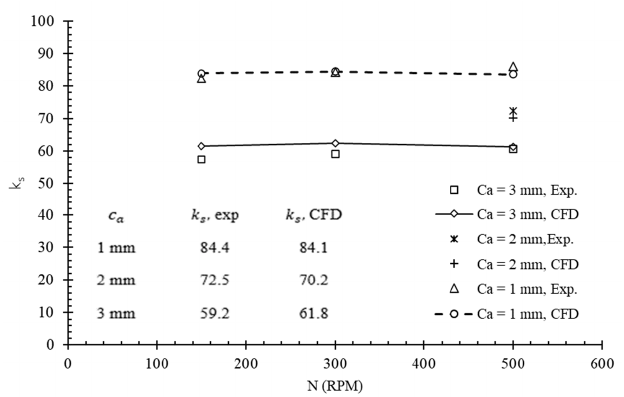
Figure 8. Calculated k s values from the experiments and simulations.